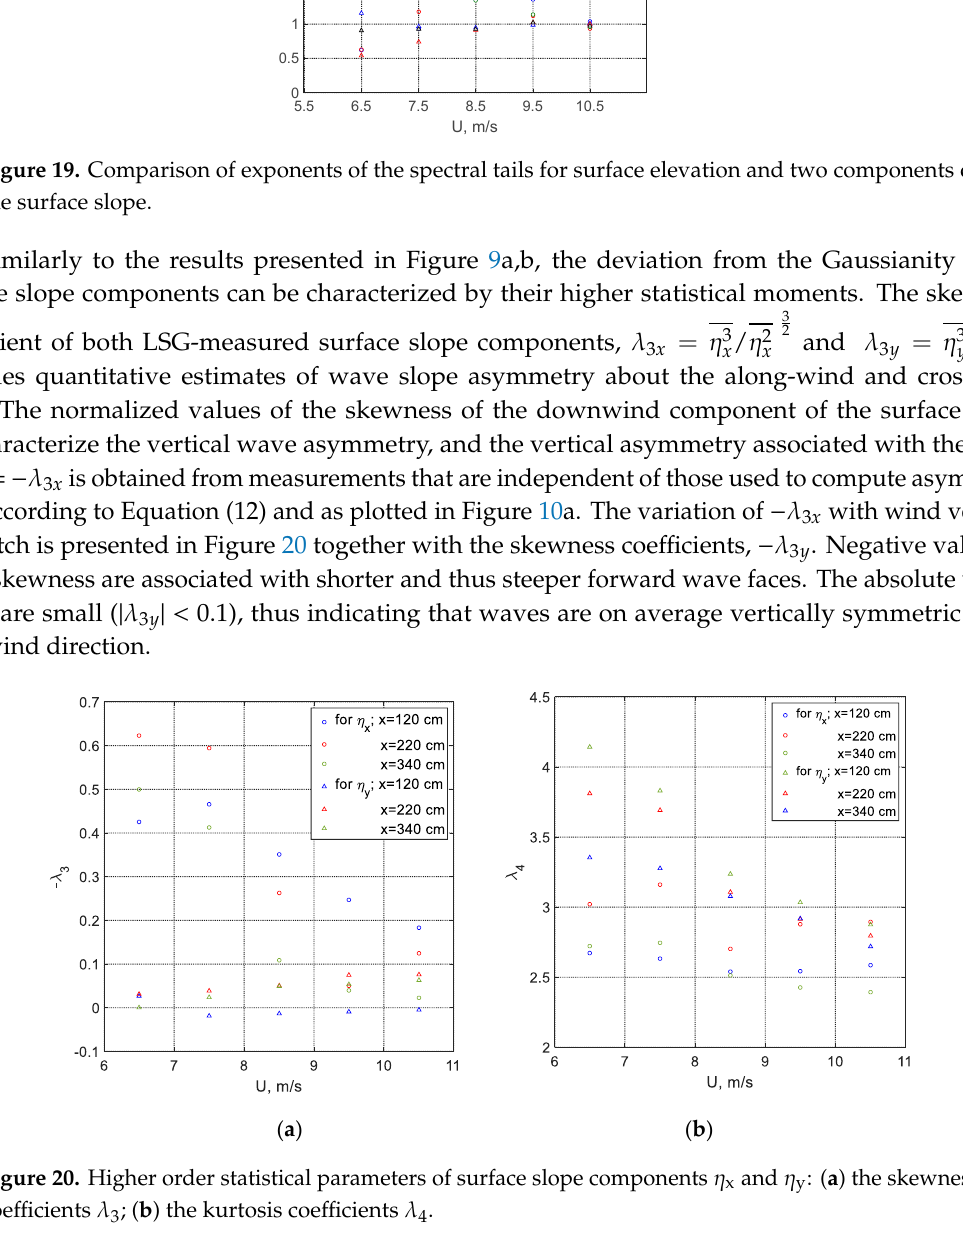
Figure 19. Comparison of exponents of the spectral tails for surface elevation and two components of the surface slope.